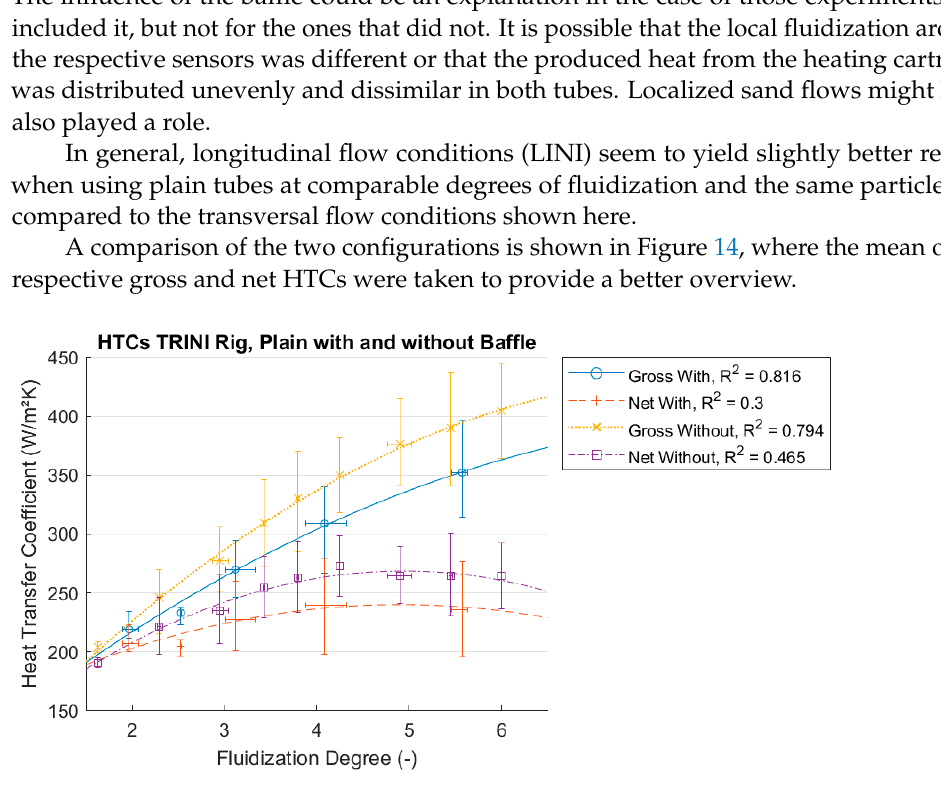
Figure 13. Plain tube results when using baffles, TRINI test rig, 146 µm particles. Indices 1 and 2 refer to the different heated tubes.